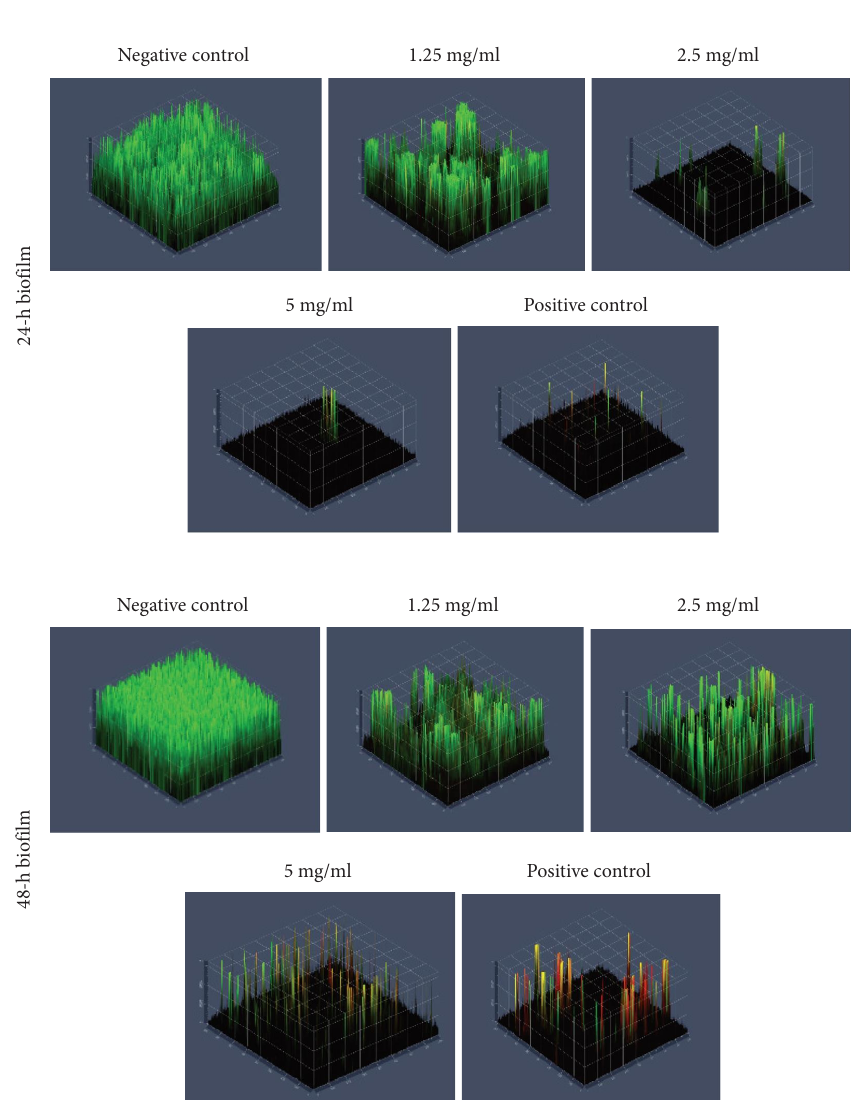
Figure 2: Representative 3D CLSM images of 24h and 48 h S. mutans and S. sanguinis bioflms after exposure with varying concentrations of PSNC. Te bioflm masses decrease as the concentrations of nano chitosan increase.